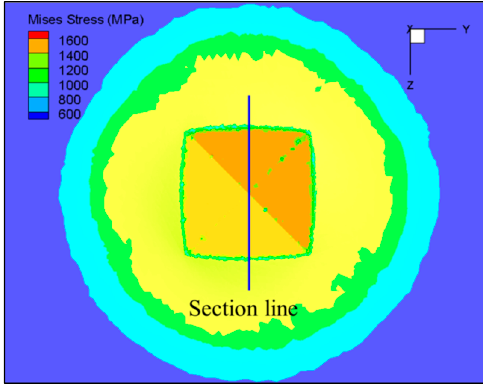
Figure 17. Stress contour of indentation (Temperature = 20 °C, Load = 10 kg).